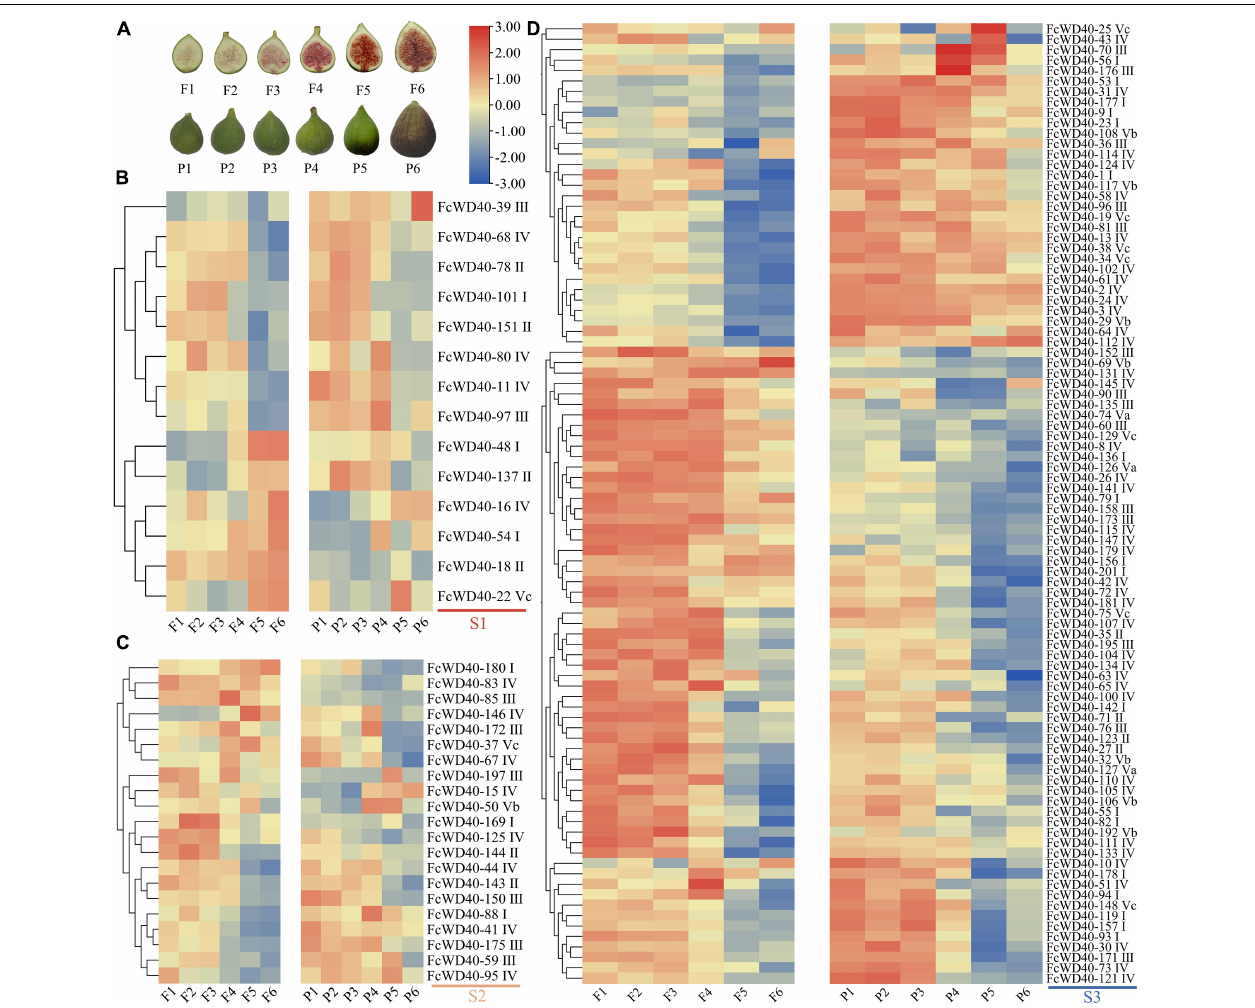
FIGURE 3 | Expression profiles of FcWD40 genes in the flesh and peel tissue of developing and ripening fruit. (A) Photographs of fig flesh and peel color at different stages. (B) Members of FcWD40 in group S1 (FPKM ≥ 100). (C) Members of FcWD40 in group S2 (100 > FPKM ≥ 50). (D) Members of FcWD40 in group S3 (50 > FPKM > 10). Color bars represent level of downregulation (blue) and upregulation (red).